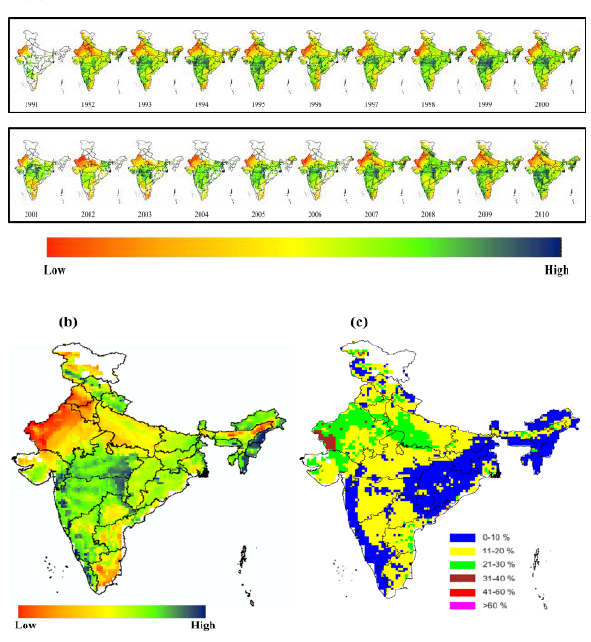
Figure 4: a) July month’s mean soil moisture images for